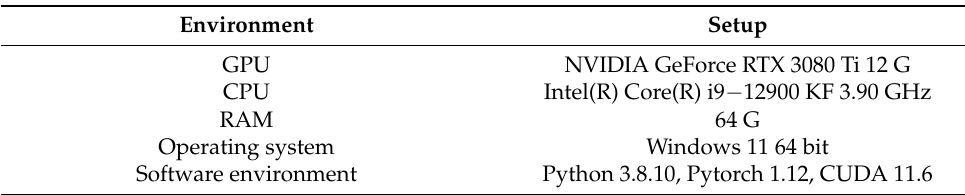
Table 1. Training and testing environment.